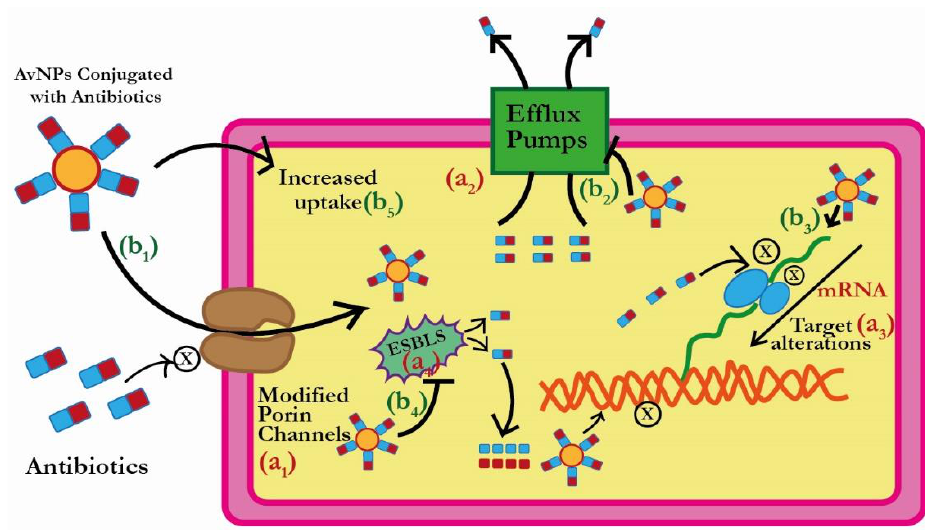
Figure 4. Comparison between ( a ) bacterial resistance mechanism and ( b ) plausible mechanism of action of AuNPs to overcome resistance . ( a1 ) Modification of porins to hinder the entry of antibiotics, whereas ( b1 ) same antibiotics, once loaded to AuNPs, gain easy entry into the bacterial pathogen; ( a2 ) efflux of antibiotics from bacteria to outside of the cell, whereas ( b2 ) inhibition of efflux pumps/decreasing expression of efflux pump genes by AuNPs; ( a3 ) alteration of antibiotic target site, whereas, ( b3 ) indirect/direct targeting of bacterial biomolecules by AuNPs; ( a4 ) Antibiotic inactivating enzymes (ESBLs), whereas ( b4 ) saturation of enzymes or direct damage to the enzyme structure by AuNPs. In addition, ( b5 ) AuNPs can directly interact with the cell barriers, causing perforation and cell lysis.